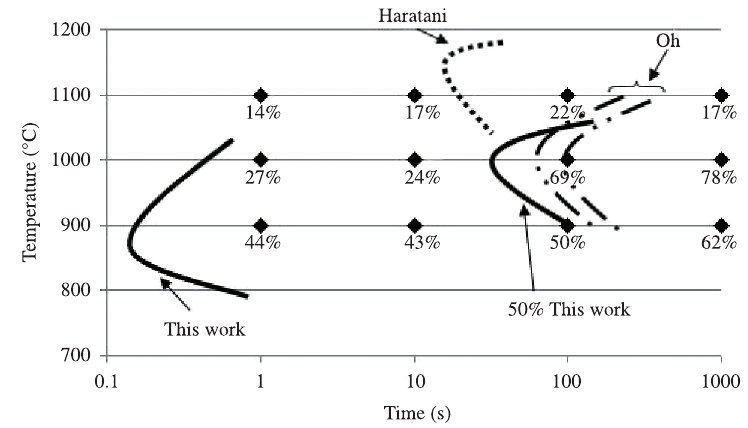
Figure 5. PPT curves for AlN in 3%Si-Fe obtained from this